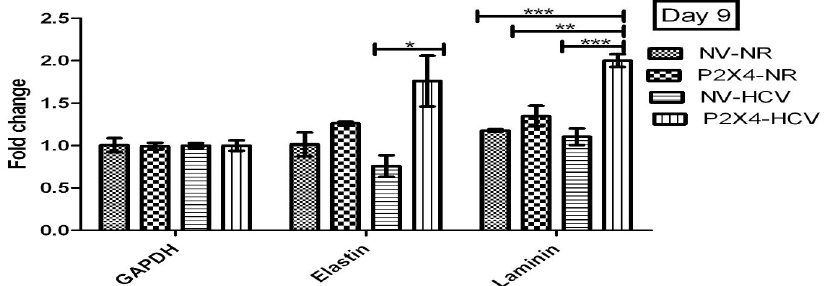
Fig 18. Expression of various cytokines on day 9 of post infection. All values are expressed as mean ± SEM, � P � 0.05 vs. control NV/HCV.